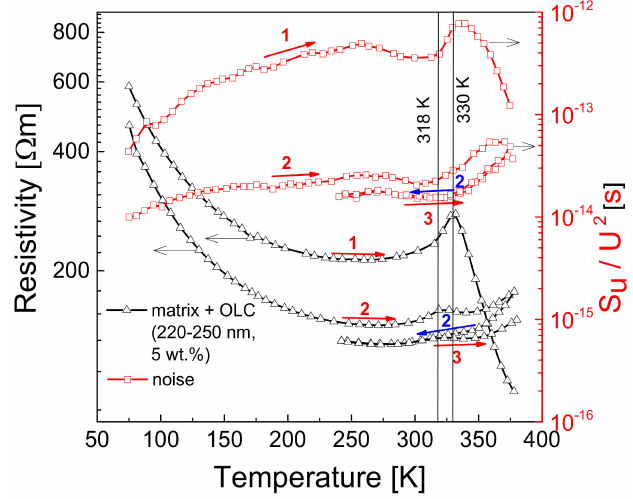
Figure 12. Resistivity and the voltage noise dependencies on temperature for a material with 5 wt.% of (220–250) nm OLC particles during repeated cycles of cooling (blue arrows) and heating (red arrows). The numbers indicate the cycle